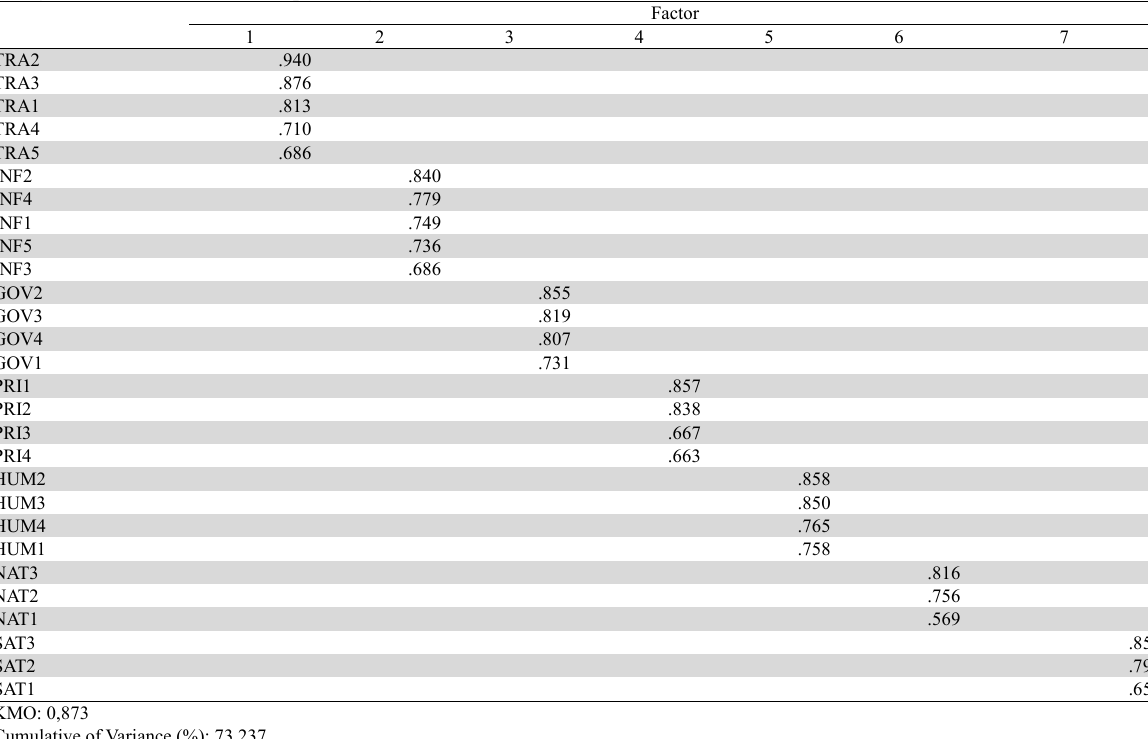
Analysis result of the second exploratory